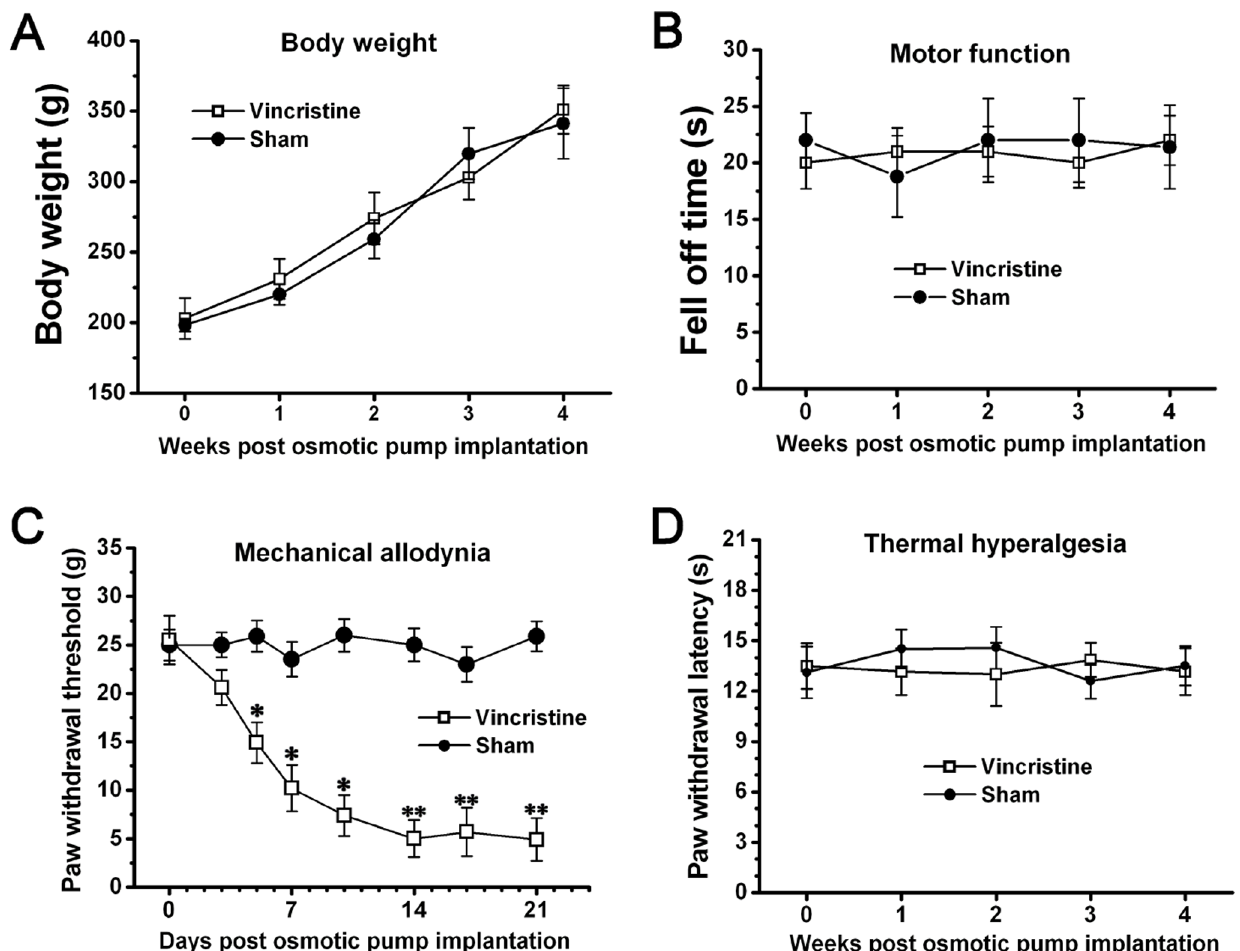
Figure 1. Mechanical allodynia occurred in vincristine treated rats. With regard to (A) body weight and (B) motor function, there was no difference between Vincristine group and Sham group. (C) Compared to Sham group, the paw withdrawal threshold of Vincristine group was significantly decreased. (D) No significant changes in thermal withdrawal thresholds were observed between Vincristine group and Sham group. All data were calculated as mean 6 SEM (n=10/group). *P , 0.05, **P , 0.01 vs. Sham group in C.